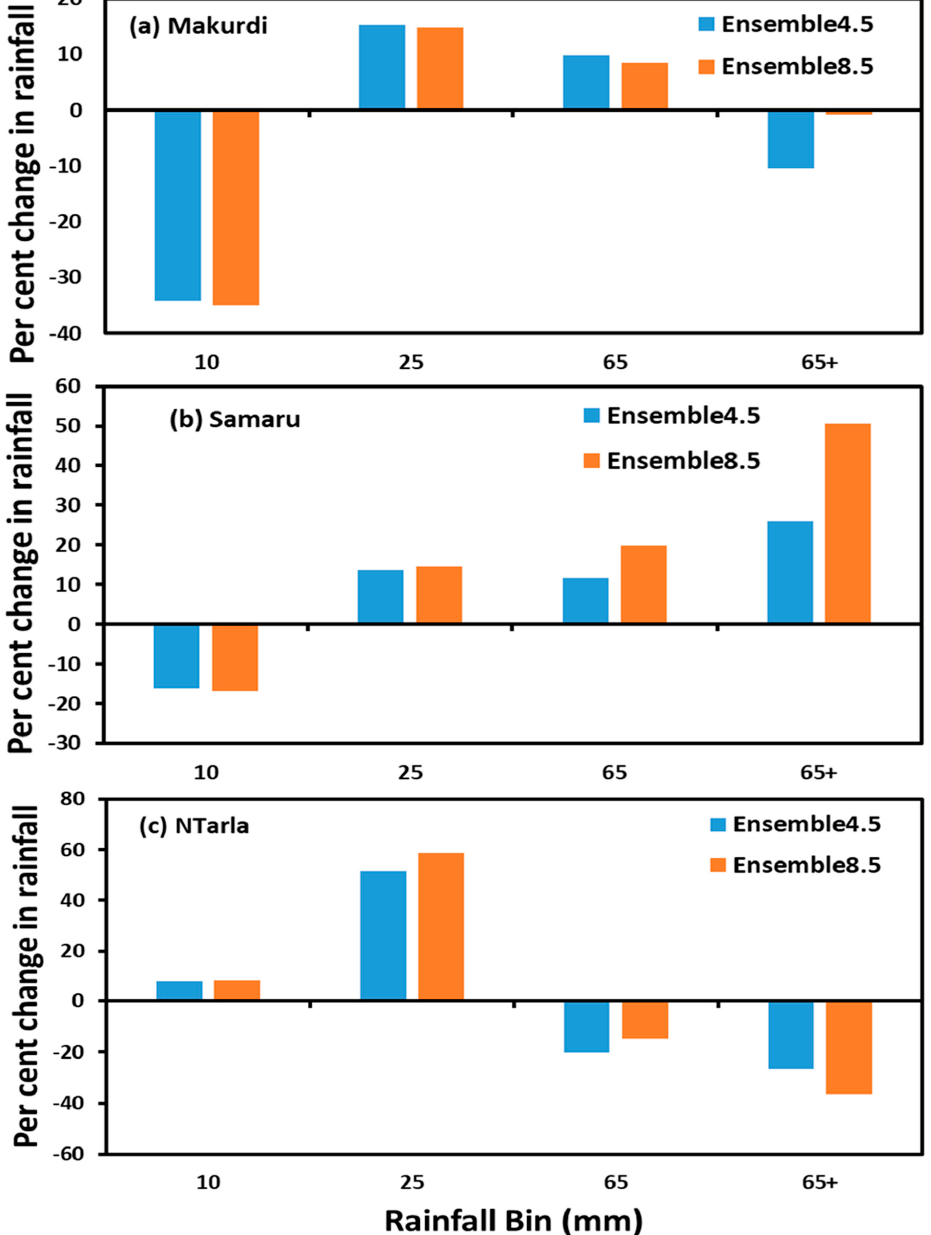
Figure 6. ( a ) Southern (Makurdi) and ( b , c ) Northern (Samaru and NTarla) Guinea average ensemble change in the frequency of the rainfall events at different intensities for the future (2021/2025–2050) relative to the baseline (1976/1980–2005).